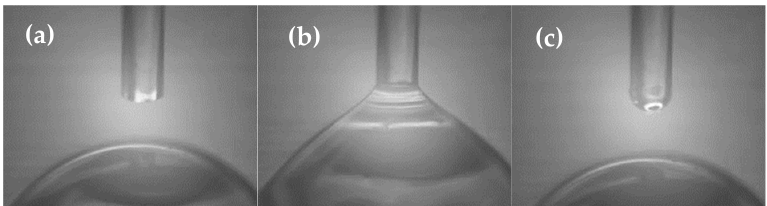
Figure 3. The CCD camera-recorded immersion process: ( a ) the optical fiber end slightly above the droplet of IL, ( b ) the contact with the surface of the ILs droplet, ( c ) small droplet of IL on the end of optical fiber ready for imprinting.